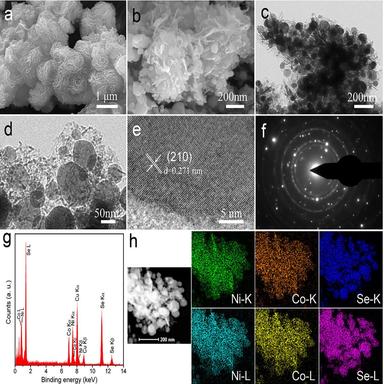
SEM images of the (a) Ni–Co hydroxide precursor and (b) Ni0.67Co0.33Se2. (c–e) TEM images, (f) selected area electron diffraction pattern, (g) EDS spectrum and (h) EDS elemental mapping images of the Ni0.67Co0.33Se2 sample.